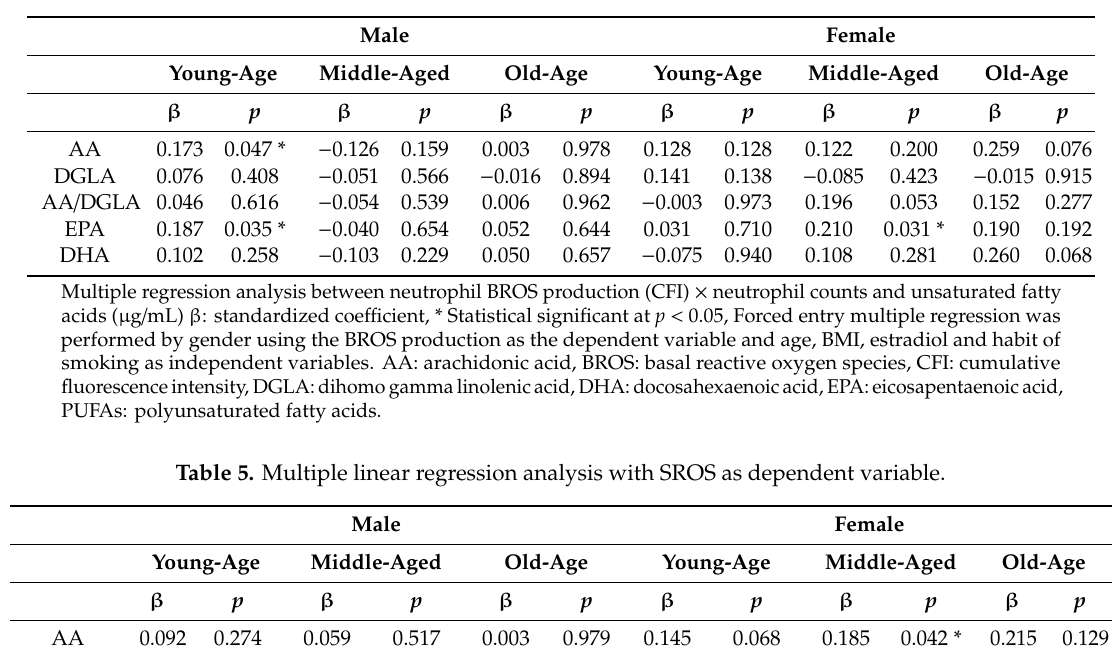
Table 4. Multiple linear regression analysis with BROS as dependent variable.